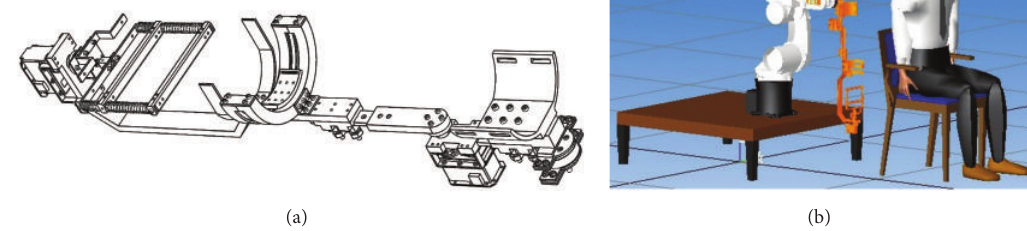
Figure 1: The first prototype of FMS (a) and the configuration of SEFRE Rehab System with a user